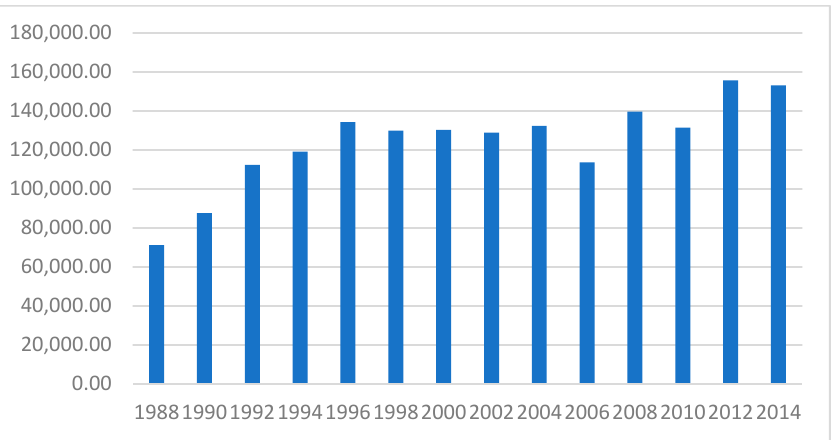
Figure 2. European production of continental products EU (15) (millions of euros, current prices). Source: own elaboration based on data obtained from EUROSTAT.